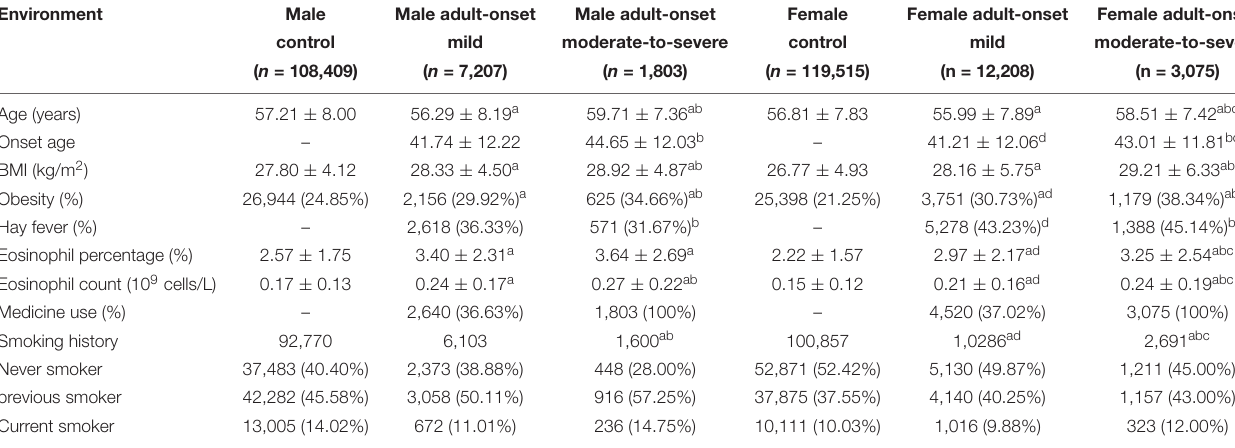
TABLE 3 | Characteristics of the adult-onset asthma cases and controls from the UK Biobank. Environment Male Male adult-onset Male adult-onset Female Female adult-onset Female adult-onset